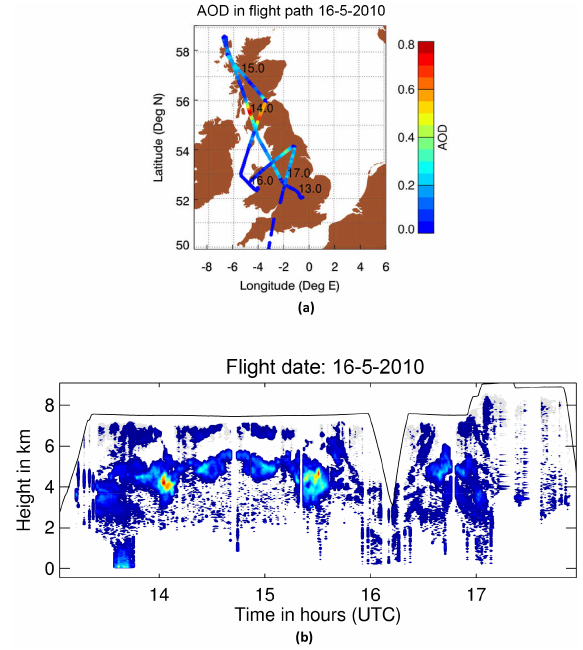
Figure 1. Characteristics of the FAAM flight of 16 May 2010. The flight track coloured according to AOD (a) , and the flight altitude vs. time in UTC along with a time–altitude cross section for the aerosol extinction coefficient at 355nm (in Mm − 1 ) measured with the aircraft lidar (b)